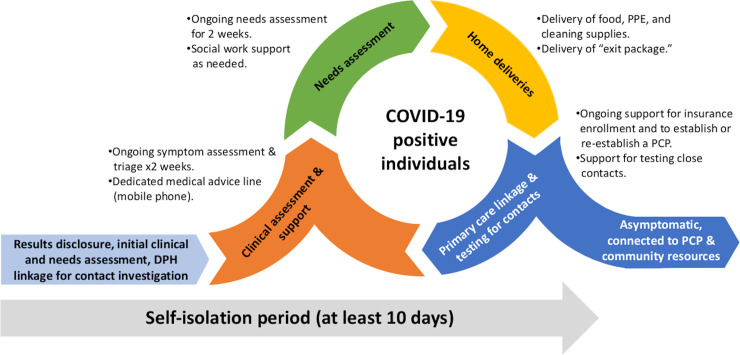
Overview of the Test-to-Care Model.